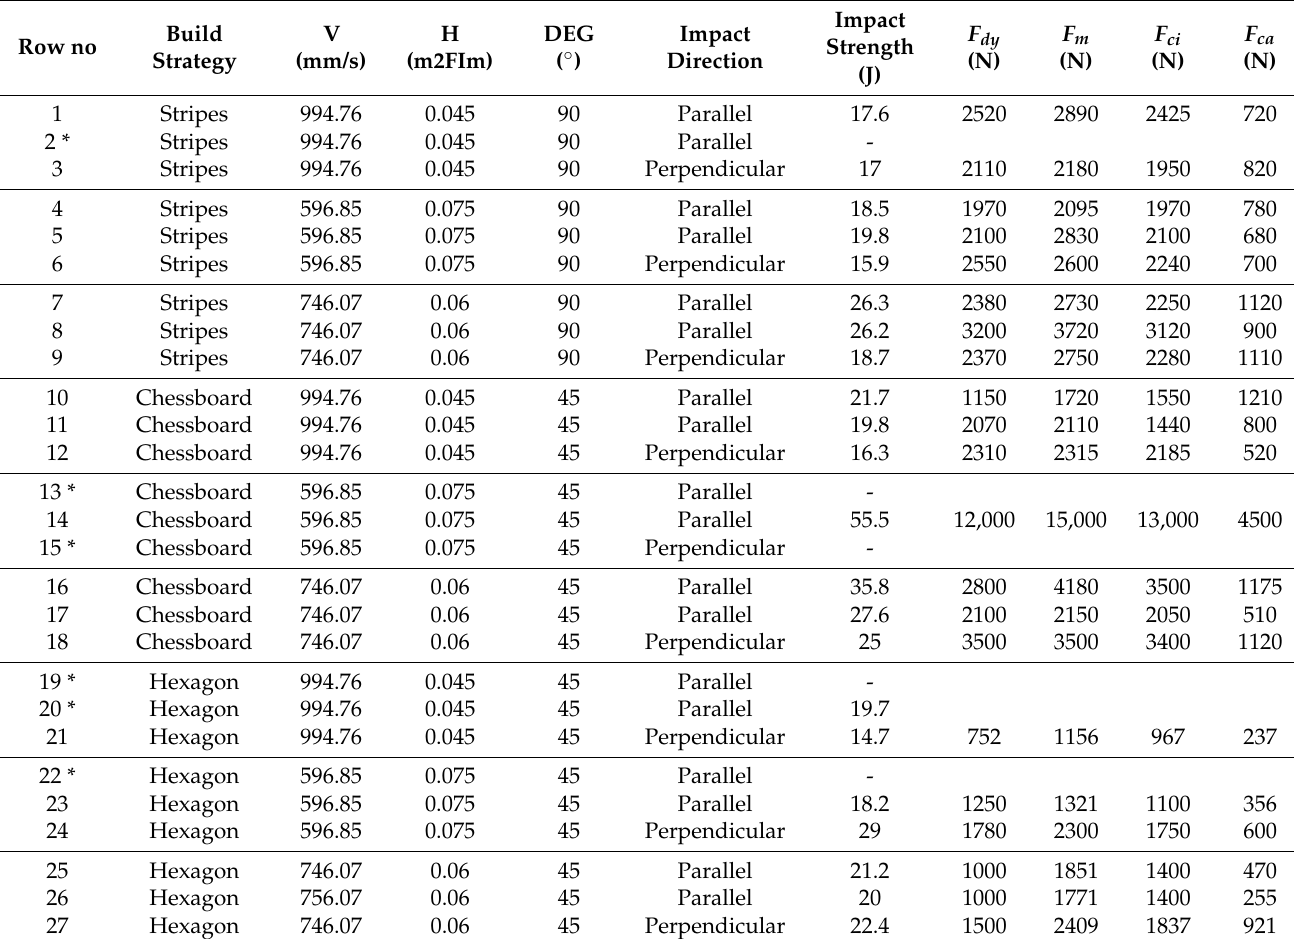
Table 3. Process parameter setting for the experiments made.